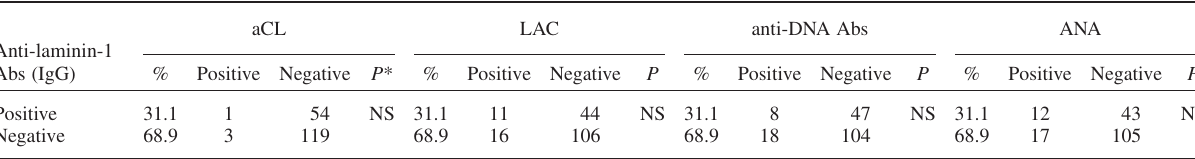
TABLE II Relationship in the prevalence of anti-laminin-1 autoantibodies, b 2 -GPI-dependent aCL, LA, aDNA and ANA in recurrent aborters